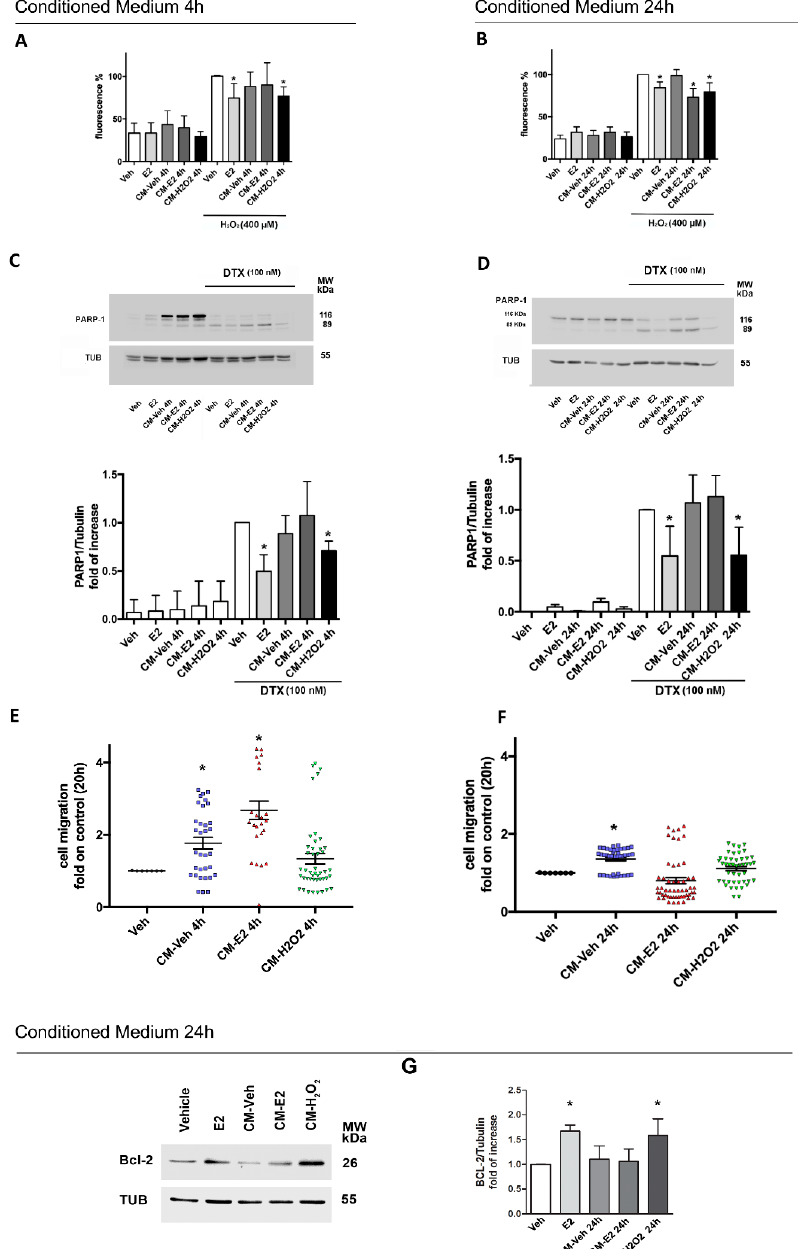
Figure 5. Effects of homotypic conditioned medium on MCF-7 cells phenotype. MCF-7 cells were treated in homotypic way with conditioned media obtained as reported in Figure S1 from MCF-7 cells stimulated with vehicle (EtOH/PBS 1/10 v/v), E2 (10 nM, 30 min), or H 2 O 2 (200 µM; 30 min) and further cultured for 4 h (CM-Veh 4 h, CM-E2 4 h, CM-H 2 O 2 4 h; left side) or 24 h (CM-Veh 24 h, CM-E2 24 h, CM-H 2 O 2 24 h; right side). Effects of 4 h pretreatment conditioned media 4 h (CM 4 h) or 24 h (CM 24 h) on ROS generation in presence or absence of cells exposure to H 2 O 2 (400 µM; 30 min) ( A , B ) and on PARP-1 cleavage in presence or absence of DTX stimulation (100 nM; 48 h) ( C , D ). E2 (10 nM; 4 h) pretreatment was used as positive control. In PARP-1 analysis, the amount of protein was normalized by comparison with tubulin levels. Upper panels are representative Western blots and bottom panels are corresponding densitometric analysis ( C , D ). Cell migration analysis of MCF-7 treated with conditioned media 4 h ( E ) or 24 h ( F ) for 20 h. Bcl-2 levels in MCF-7 treated with E2 (10 nM, 30 min),